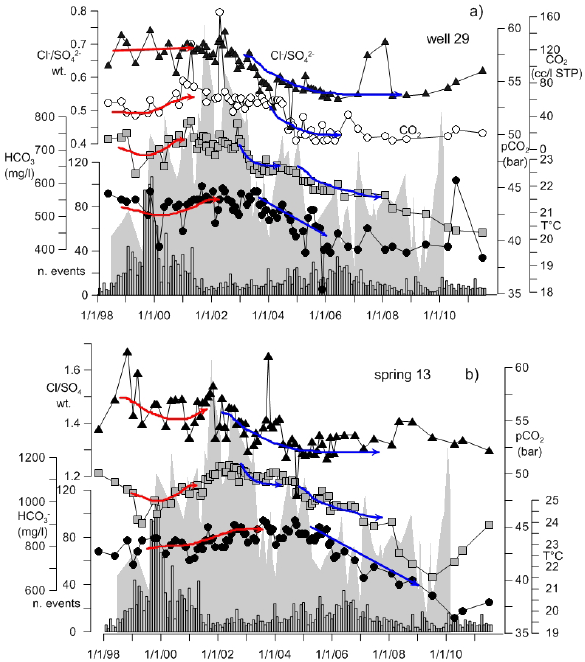
Figure 5. a) From top to bottom: time trends of the Cl − /SO 42− ratio content (open circles), HCO 3− content (triangles), dissolved CO 2 (squares), and water temperature (filled circles) at well 29 (Torre del Greco). b) From top to bottom: time trends of the Cl − /SO 42− ratio (triangles), HCO 3− content (squares), and water temperature (filled circles) at spring 13 (Torre Annunziata). Arrows indicate phases of increases (red) and decreases (blue) in the plotted parameters. The values, computed for the hydrothermal aquifer time trend of pCO 2 by Caliro et al. [2011], is plotted as a shaded area. The histogram shows the monthly number of seismic events.